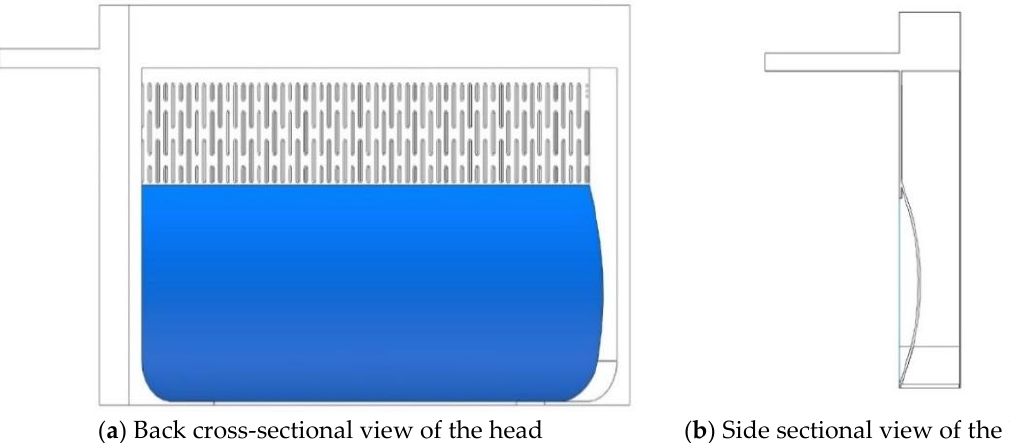
Figure 10. Integrated stove head air duct preliminary optimization program.